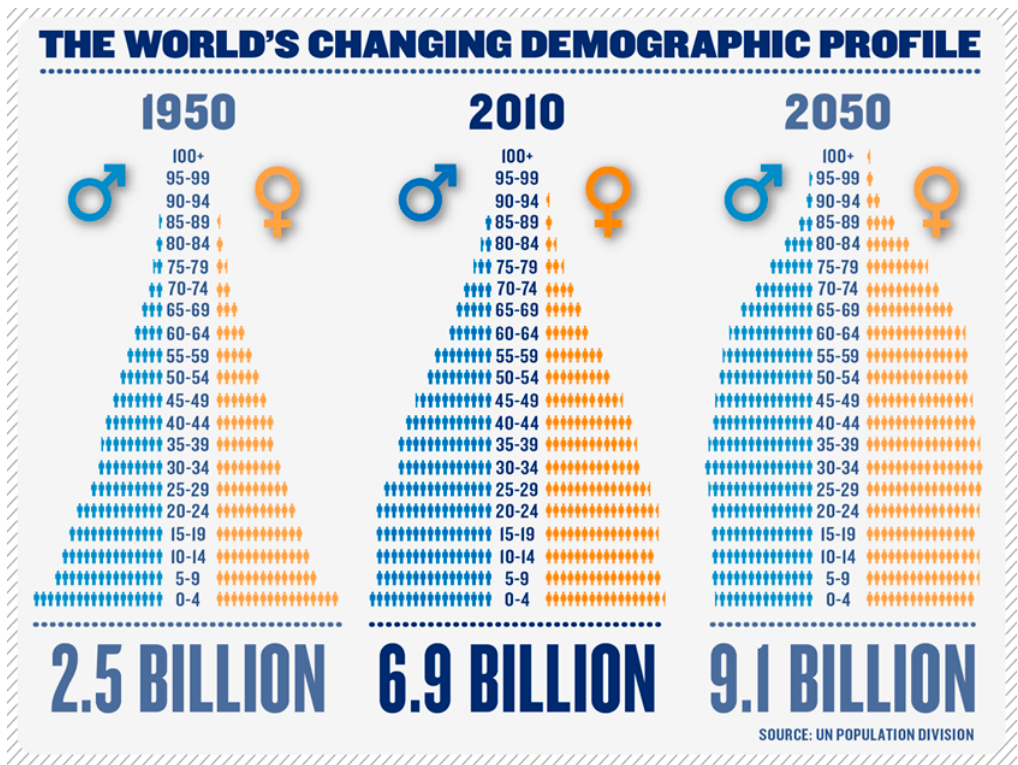
Figure 1. Changing age distribution, from the United Nations Population Division No 2012/4 December 2012. www.UNpopulation.org.